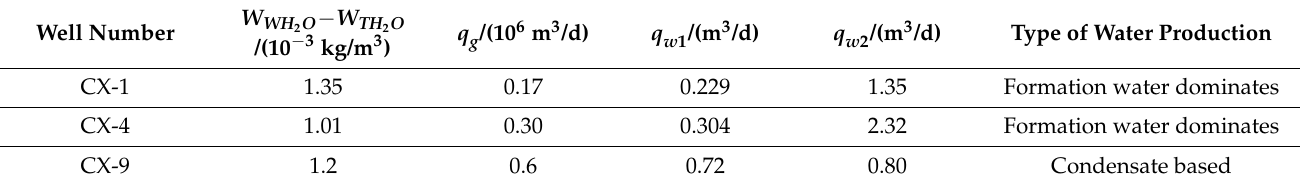
Table 3. Composition of the water produced in the gas wells.